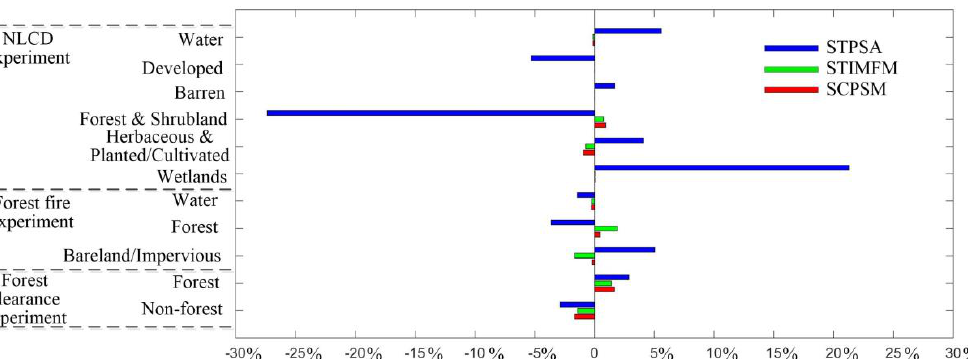
Figure 12. The absolute differences between the percentage of FR pixels of each class in the predicted and reference maps in the three experiments. Positive value means the predicted number of pixels is higher than that in the reference map for a class, and negative value means the predicted number of pixels is lower than that in the reference map for a class.